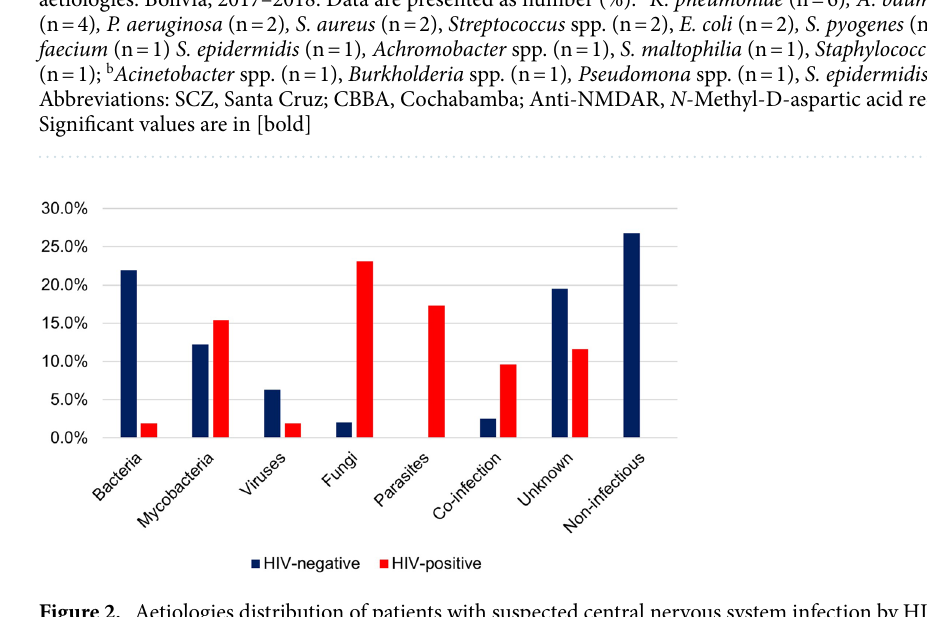
Figure 2. Aetiologies distribution of patients with suspected central nervous system infection by HIV status. Bolivia 2017–2018.